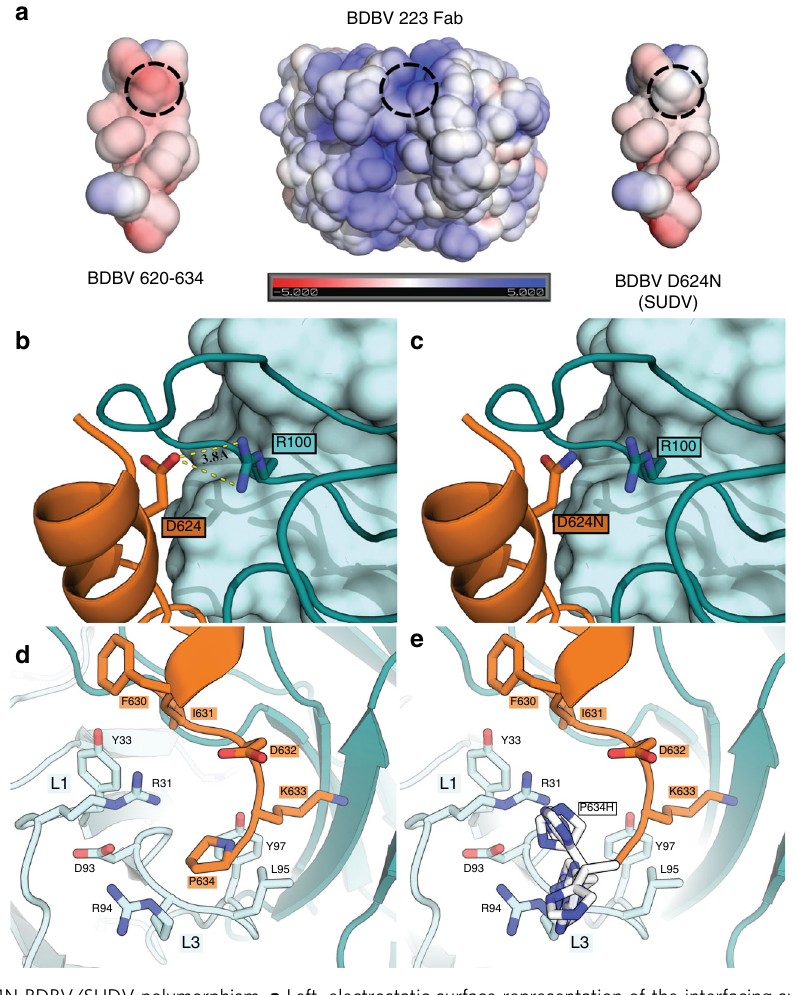
Fig. 3 Modeling of the D624N BDBV/SUDV polymorphism. a Left, electrostatic surface representation of the interfacing surfaces of the BDBV GP stalk (620 – 635). Right, model of the BDBV GP peptide bearing a D624N mutation. Center, the binding cleft of BDBV223 Fab. Replacing the acidic Asp residue for an Asn reduces the predicted electrostatic attraction at the N-terminus of the peptide. b The potential salt bridge formed between D624 and R100 would be abolished in the case of an Asn substitution, as occurs in SUDV. c CDRs H1 and H2 largely interact with H628, present in all three pathogenic ebolaviruses (EBOV, BDBV, and SUDV), with CDR H1 residue Y33 forming an apparent pi-stacking interaction with H628. d CDRs L1 and L3 interact with the C terminus of the stalk peptide and form close contacts with I631 and P634. e Based on this model, the previously described escape mutant P634H 17 would likely clash most prominently with R94. Color Scheme: